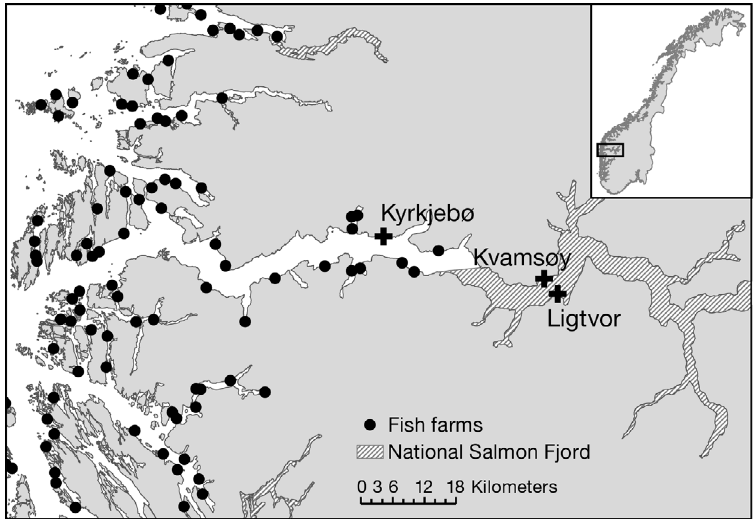
Fig. 1. Sognefjorden. Trap net locations are indicated with a black cross (Ligtvor, 61.10354°N, 6.54044°E; Kvamsøy, 61.12841°N, 6.48671°E; Kyrkjebø, 6.16222°N, 5.91745°E), while farming locations are indicated with black cir- cles. Farming locations are taken from the home page of the Directorate